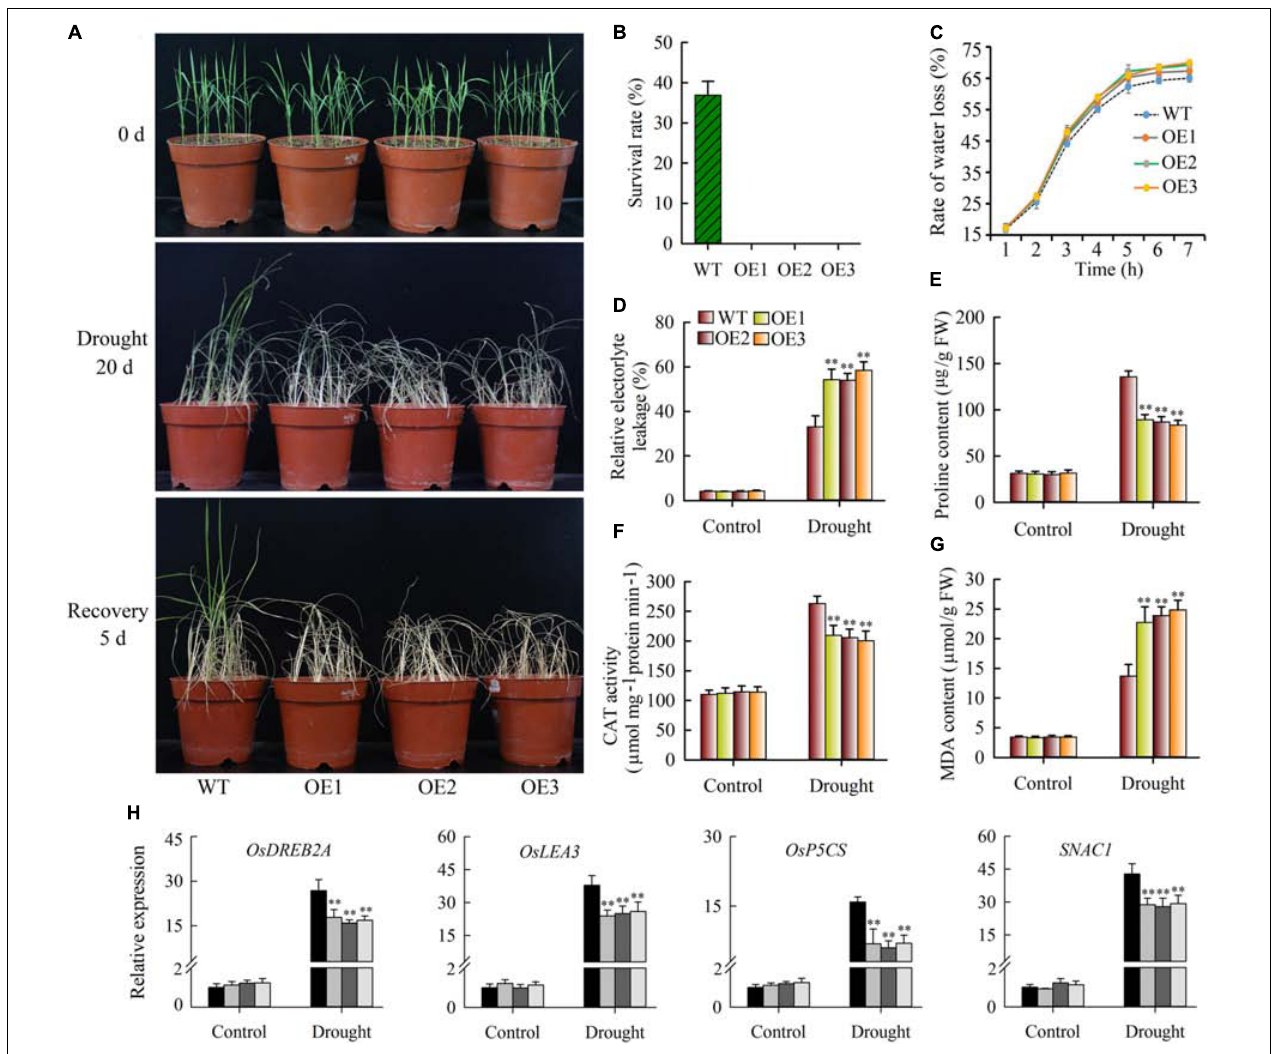
FIGURE 8 | Drought stress tolerance tests on JcWOX5 overexpressing rice plants. (A) Drought stress tolerance tests on JcWOX5 overexpressing rice lines. Two-week-old seedlings were used for drought stress treatment for 20 days, then rehydrated for 5 days. (B) The survival rate of wild-type and transgenic plants after rehydration. (C) The rate of water loss in transgenic and wild-type plants under drought stress. (D) Relative electrolyte leakage in wild-type and transgenic plants under normal growth and drought stress conditions. (E) Proline content in wild-type and transgenic plants under normal growth and drought stress conditions. (F–G) CAT activity (F) and MDA content (G) in leaves before and after drought treatment. Data in (B–G) : means of n = 20 ± SD from three independent experiments, asterisks above the bars indicate significant differences from wild-type controls at p < 0.01 according to Duncan’s multiple range test. (H) Relative expression levels of stress-responsive genes, in an experiment with three biological replicates, each with two technical replicates (means of n = 6 ± SD, asterisks above the bars indicate significant differences from wild-type controls at p <